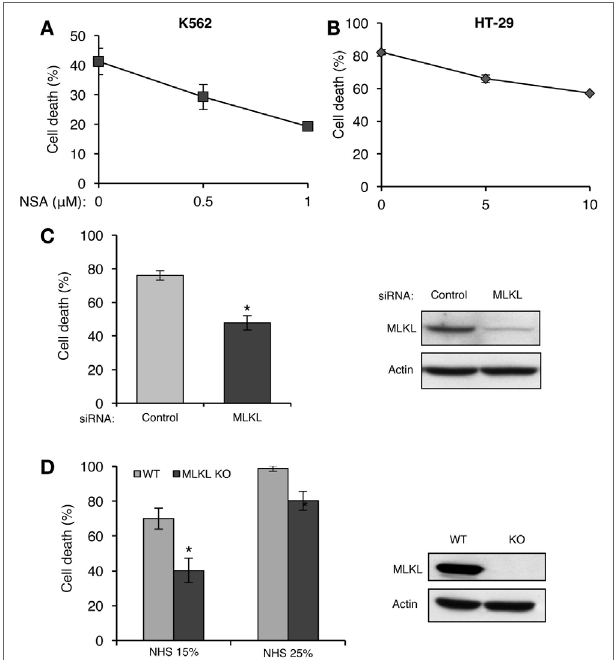
FigUre 4 | Mixed lineage kinase domain-like protein (MLKL) contributes to complement-induced cell death (CD). (a,B) K562 (a) and HT-29 cells (B) were incubated with necrosulfonamide (NSA) or with DMSO as control for 1 h at 37°C and subsequently with antibody and normal human serum (NHS). Necrotic CD was determined by propidium iodide (PI) inclusion. Results, representing three independent experiments, are expressed as the mean percentage of CD ± SD. Differences between GSK’872 and DMSO (0) treatments were all significant ( P < 0.05). (c) K562 cells were transfected with Smart Pool siRNA targeting MLKL or scrambled siRNA as a control, by electroporation. After 48 h, the cells were treated with antibody and complement for 1 h at 37°C. CD was measured by PI staining and expressed as the mean percentage of CD ± SD and the results represent three independent experiments. * P < 0.001 relative to control. Cell lysates, collected 48 h posttransfection, were subjected to Western blotting with anti-MLKL or anti-actin antibodies (shown on the right). (D) WT and MLKL KO mouse embryonic fibroblasts were treated with NHS (15 or 25%) for 1 h at 37°C. The CD percentage was measured by trypan blue inclusion. Results are the mean percentage of death ± SD. * P < 0.001 relative to WT control. Cytoplasmic aliquots were subjected to Western blot analysis of MLKL and actin levels (shown on the